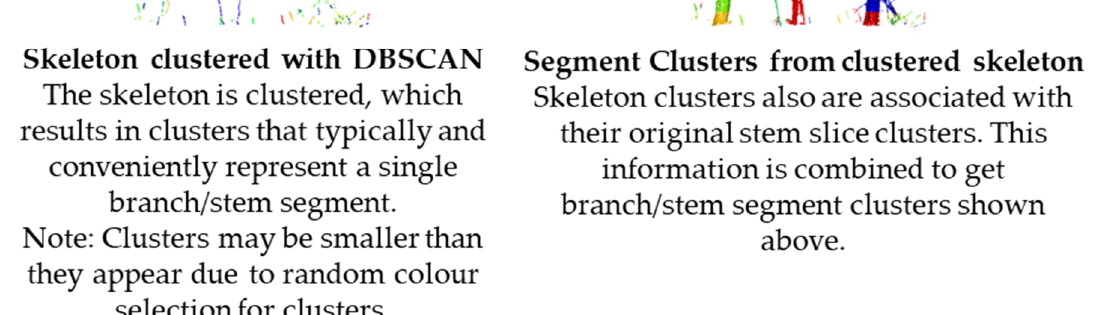
Figure 4. The skeleton ( Left graphic) is clustered using DBSCAN, such that separate branch segments form into separate clusters. The original stem points associated with each point in the skeleton are grouped together, to create segment clusters as shown in the right graphic. At this point in the process, individual trees remain undefined; only groups of points representing branches/stem sections and their skeletons are defined.